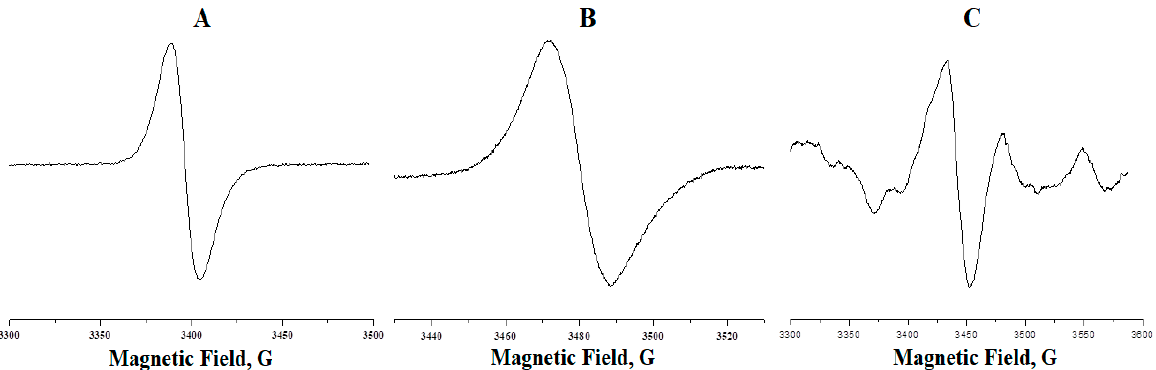
Figure 6. EPR spectra: ( A )—methylene blue; ( B )—polymethylene blue washed with five portions of distilled water, 100 mL each; ( C )—washed with 25 portions of distilled water, 100 mL each.